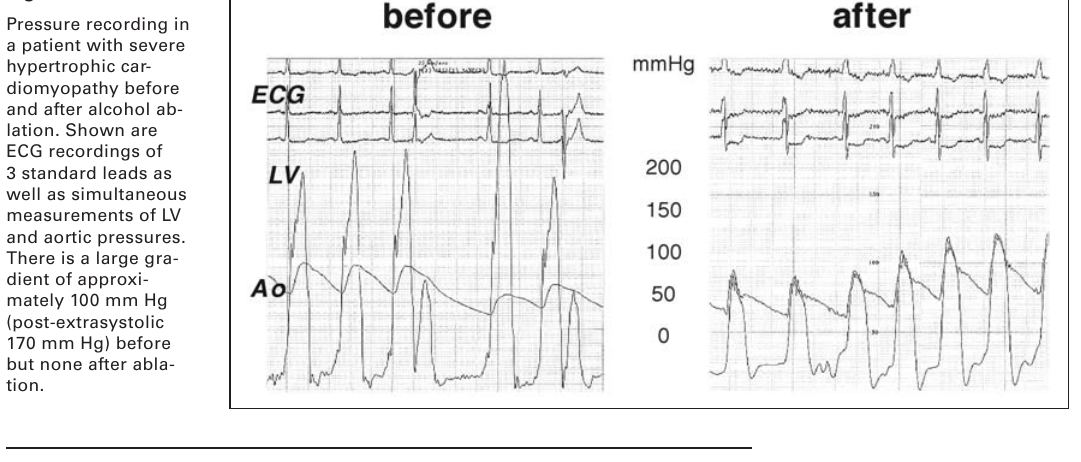
Original recording in a patient who devel- oped AV block iii dur- ing intervention. Ar- rows indicate the oc- currence of the P-wave in the eCG, respectively A-wave in the lV pressure recording, which is not follewed by a QRS complex or lV contraction.The wide QRS complex after AV block iii is induced by temporary